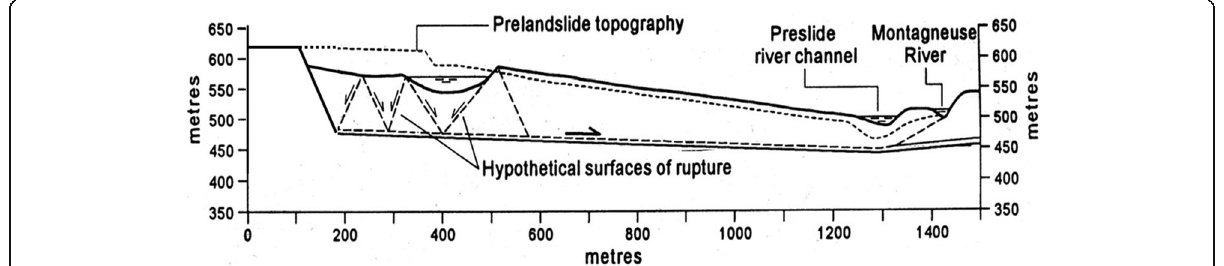
Fig. 9 Cross-section of the Montagneuse River landslide and dam. (Modified from Cruden et al.